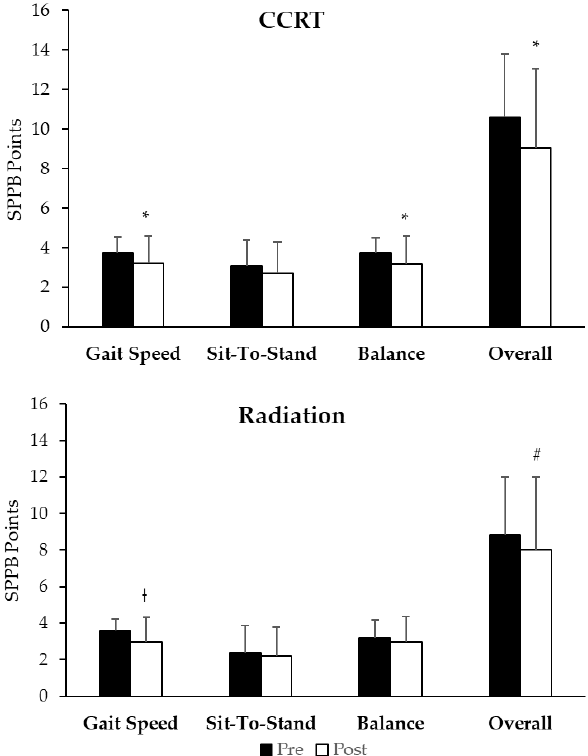
Figure 1. Short Physical Performance Battery (SPPB) scores in each category pre- (black) and post- treatment (white) for patients who received CCRT or radiation alone. Statistical significance indicated by * ( p < 0.001), † ( p = 0.009), and # ( p = 0.01).